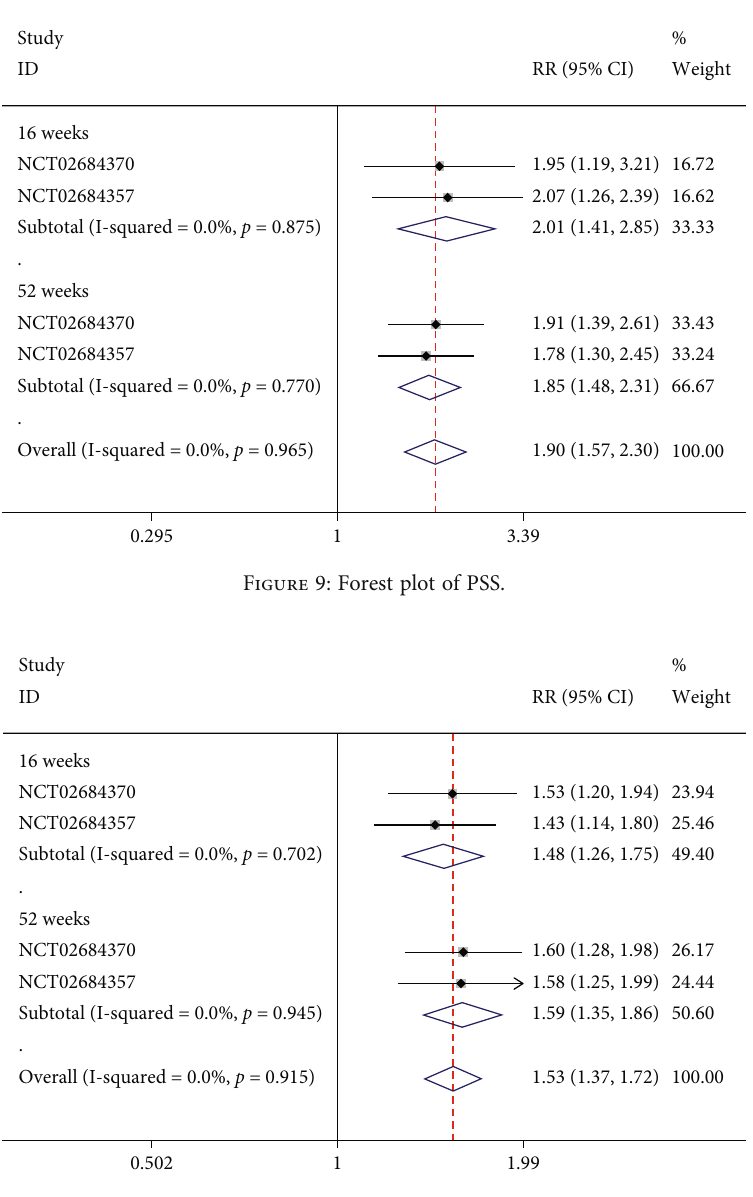
Figure 9: Forest plot of PSS.